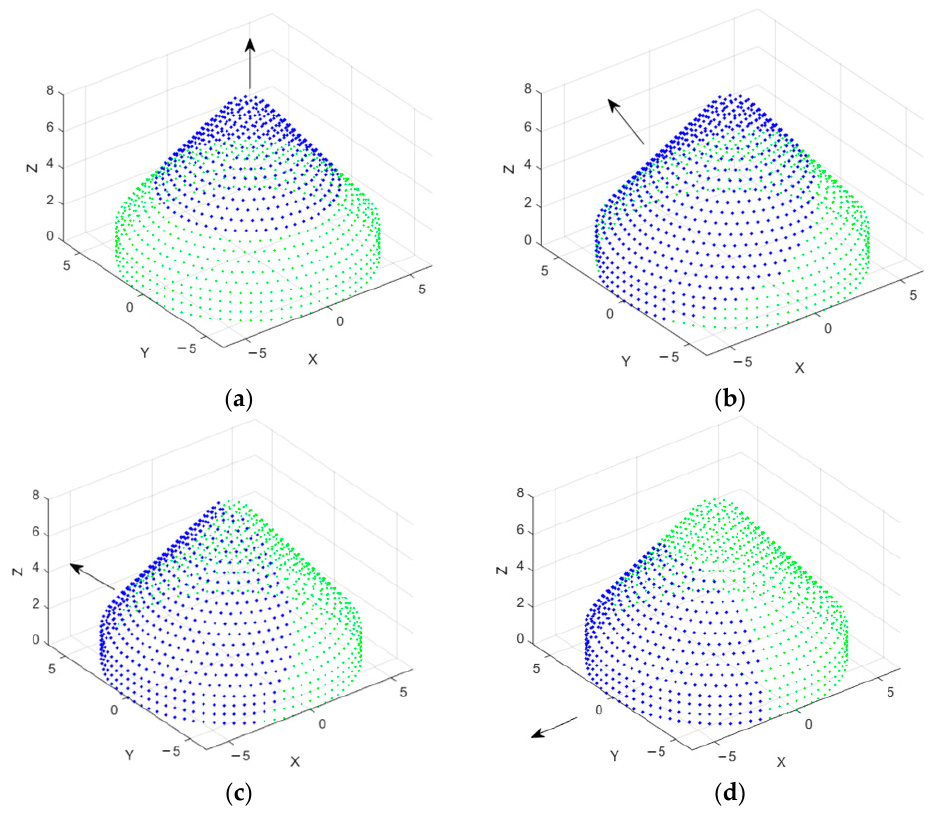
Figure 12. Frontal mainlobe-oriented partial CSC4 concept. The green dots represent the whole CSC4 array; ( a ) partial array at θ o = 0 ◦ , ( b ) partial array at θ o = 30 ◦ , ( c ) partial array at θ o = 60 ◦ , ( d ) partial array at θ o = 90 ◦ .